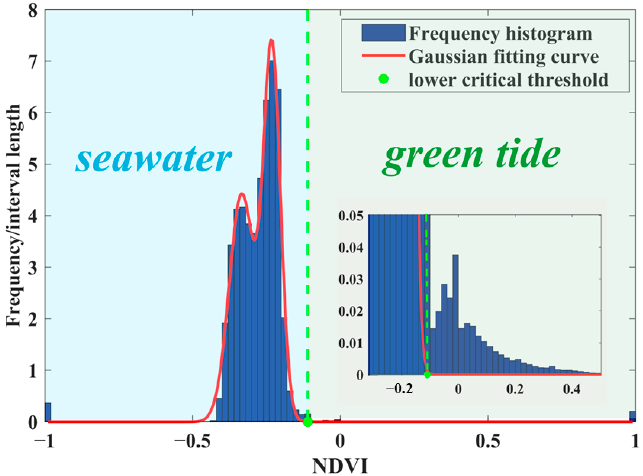
Figure 3. NDVI frequency histogram and second-order Gaussian fit curve (The data in the figure are from Landsat 8 (Date: 23 June 2021; Worldwide Reference System: path 119 and row 35).